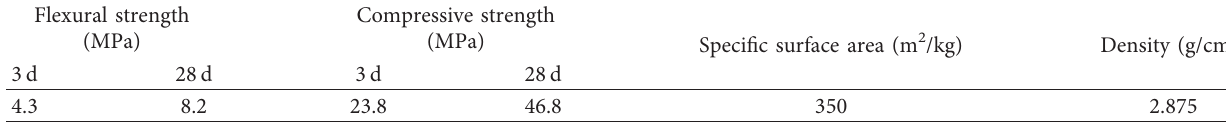
Table 1: Physical properties of cement.